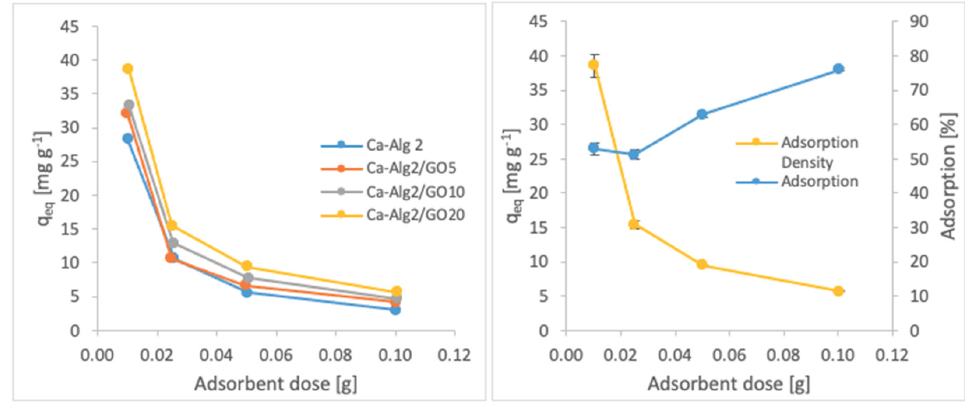
Figure 7. Effect of the adsorbent dose on qeq MB.